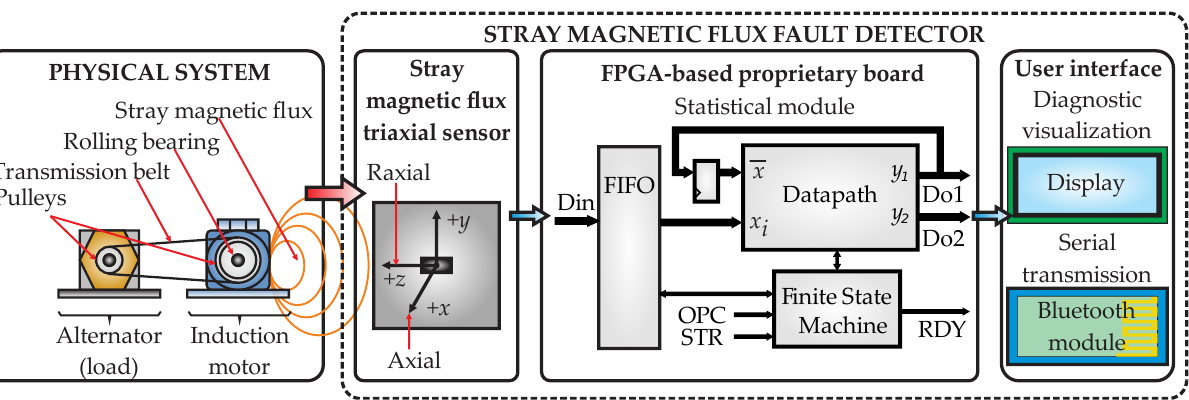
Figure 1. Block diagram of the methodology for detecting faults in the outer race of rolling bearings through the